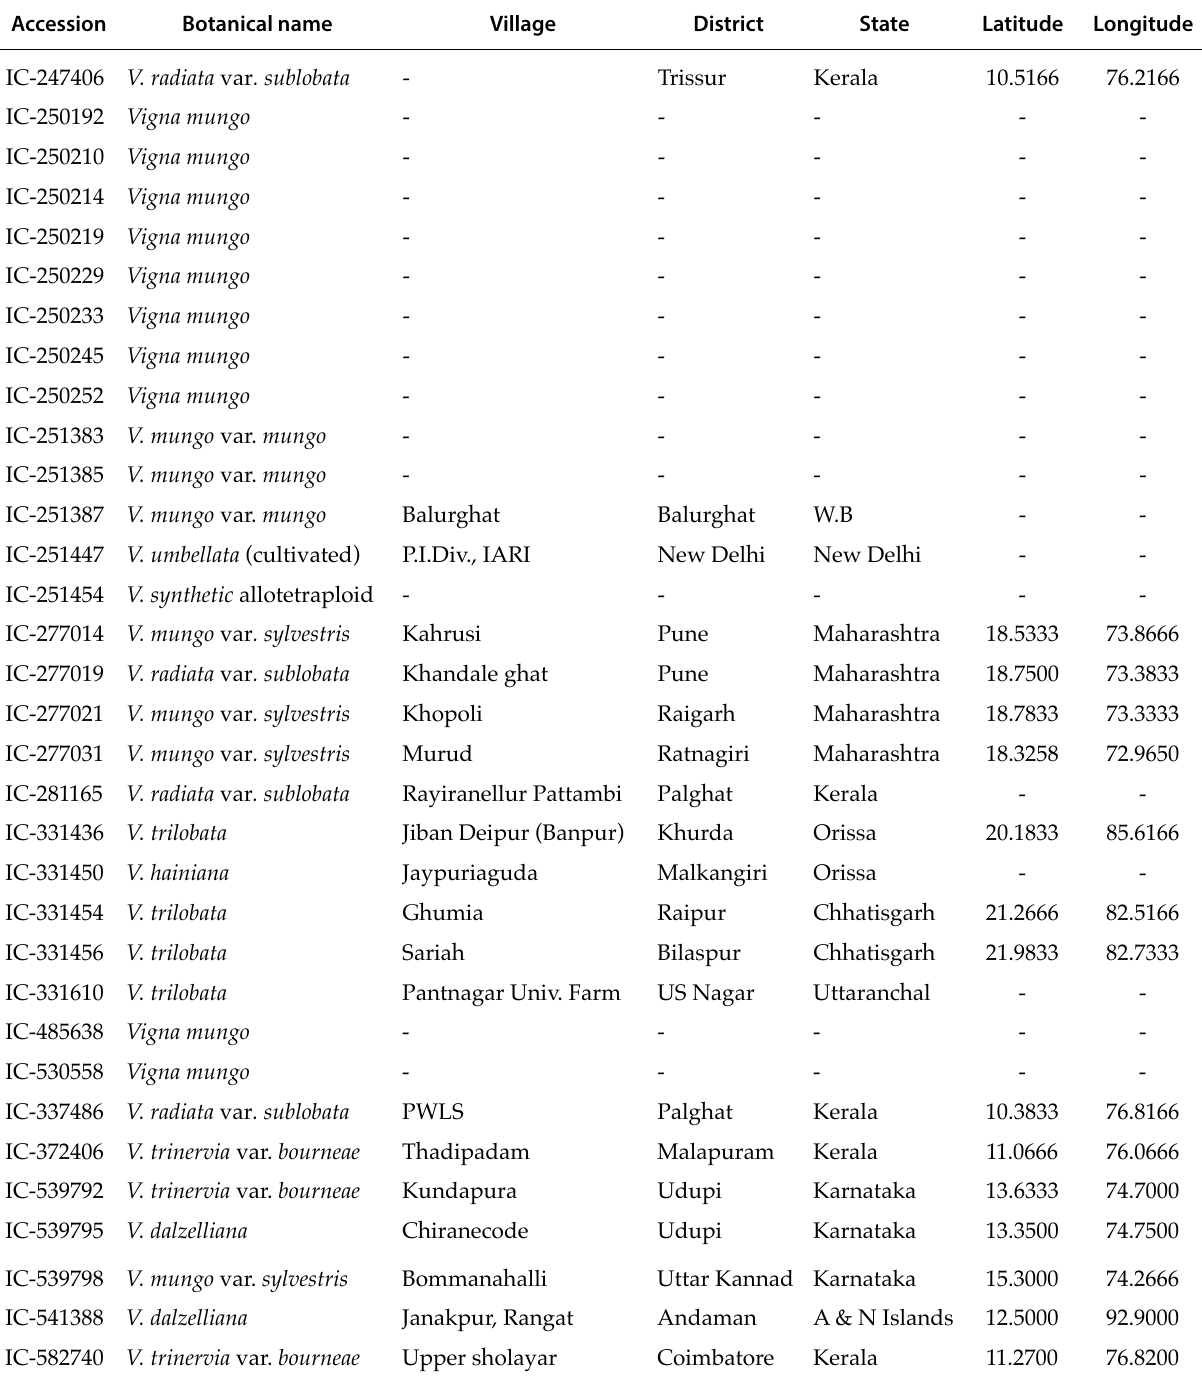
Table 2. Vigna species assessed in this study for resistance to yellow mosaic disease, with information on where they were